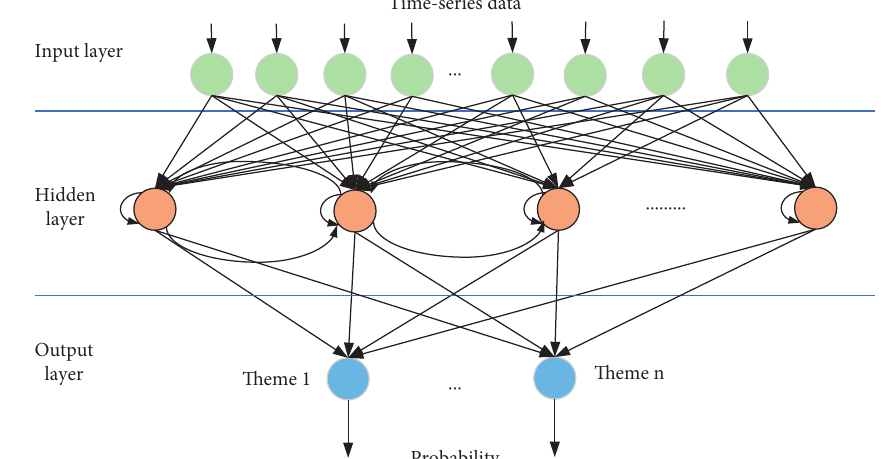
Figure 4: The structure of cross marketing strategy based on the data mining